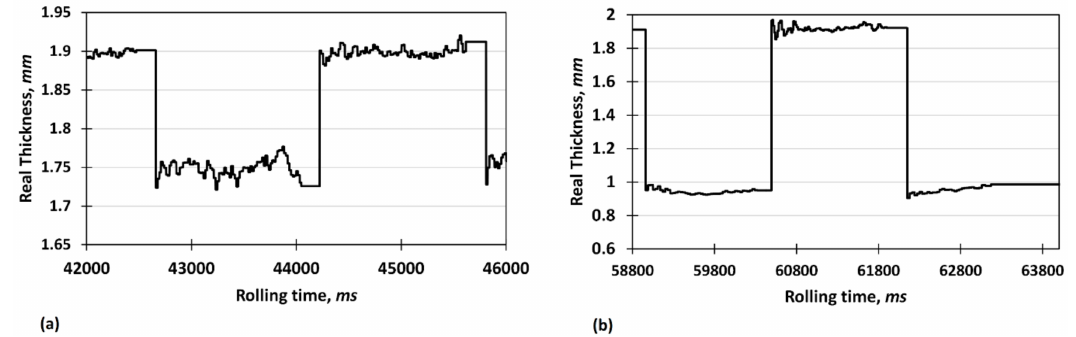
Figure 2. Variations of real thickness with rolling time for ( a ) absolute thickness reduction of 0.2 mm and ( b ) absolute thickness reduction of 1